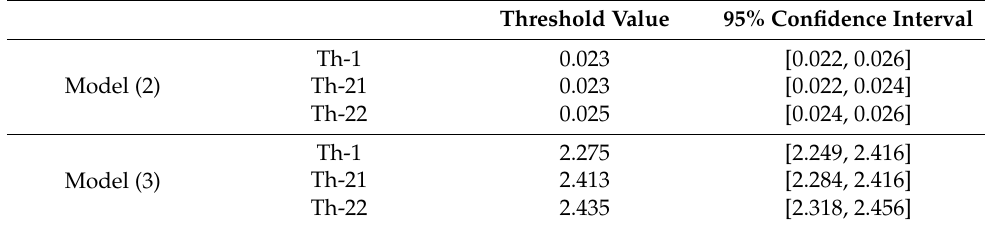
Table 6. Estimation results of threshold values for Models (2) and